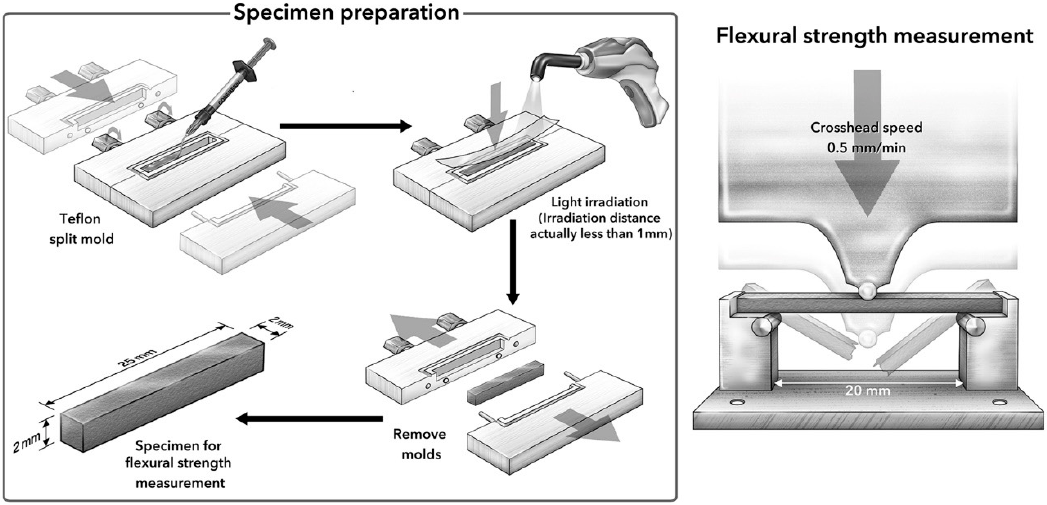
Figure 1. Schematic illustration of set-up for flexural strength